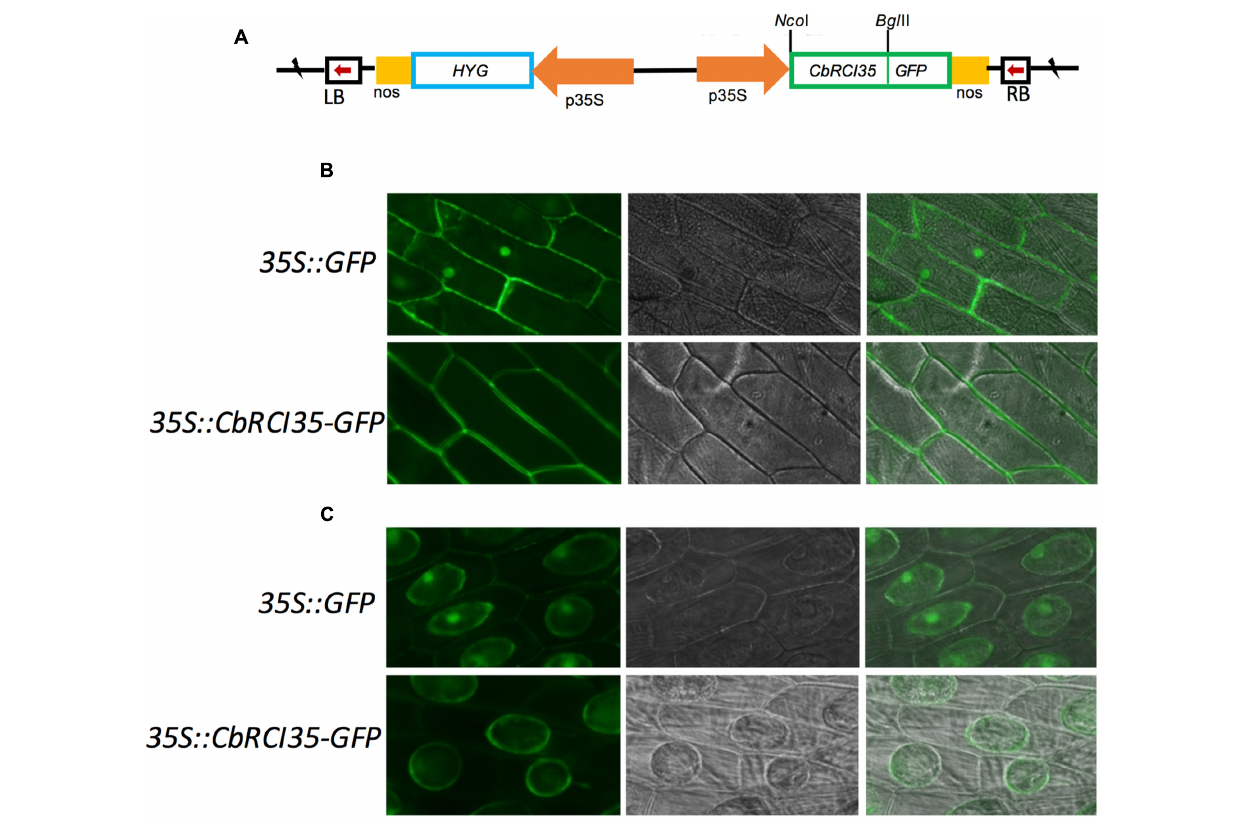
FIGURE 4 | Subcellular localization of CbRCI35 protein. (A) The structure of 35S::CbRCI35-GFP fusion plasmid. (B) Subcellular localization of CbRCI35 in onion epidermis cells. (C) GFP signal in onion epidermis cells after plasmolysis in 2 g/ml sucrose solution. Photographs of cells expressing CbRCI35-GFP fusion protein and GFP only were taken in bright light to observe cell morphology (middle) and in dark-field to observe green fluorescence (left). The right ones are merged pictures.